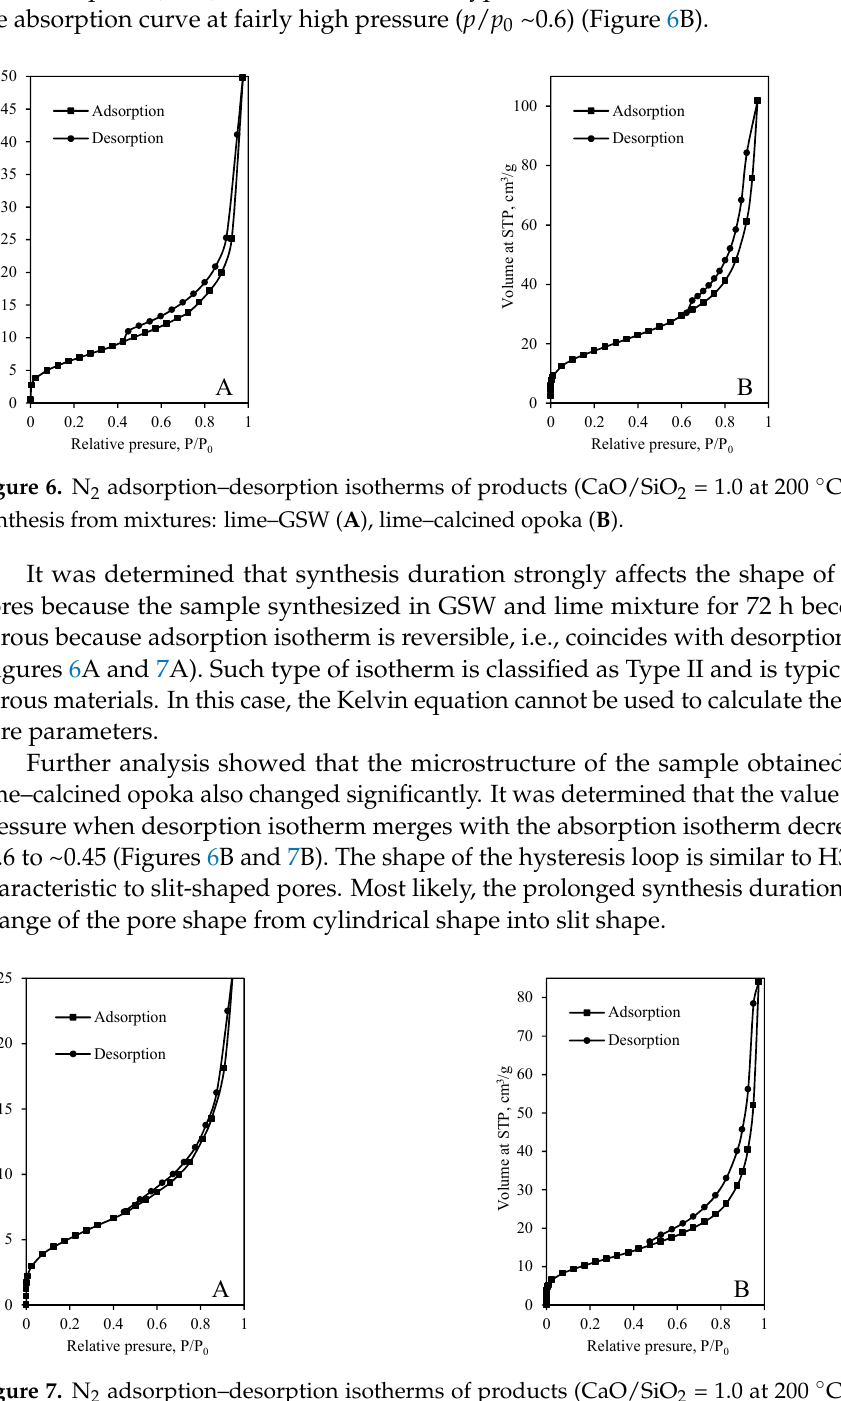
Figure 7. N 2 adsorption–desorption isotherms of products (CaO/SiO 2 = 1.0 at 200 °C) after 72-h synthesis from mixtures: lime–GSW ( A ), lime–calcined opoka ( B ).